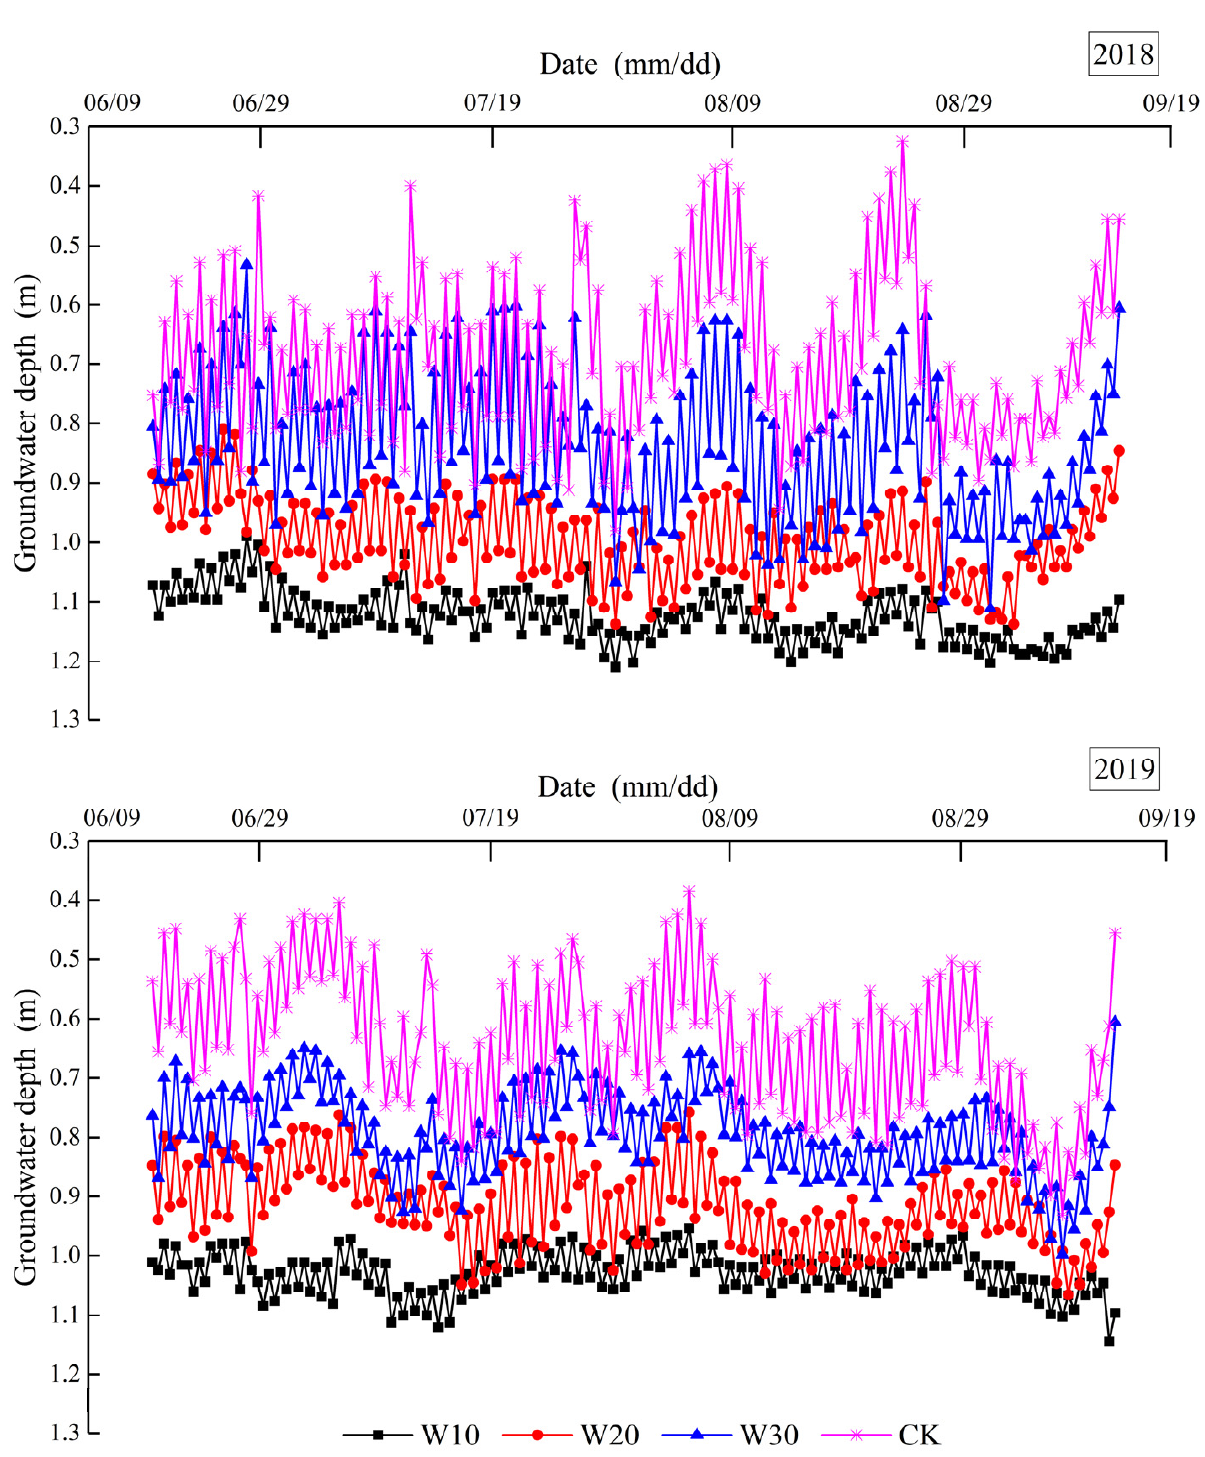
Figure 7. Groundwater table. W10, W20, and W30 mean the drain spacing of 10, 20, and 30 m, respectively. CK means no drainage.